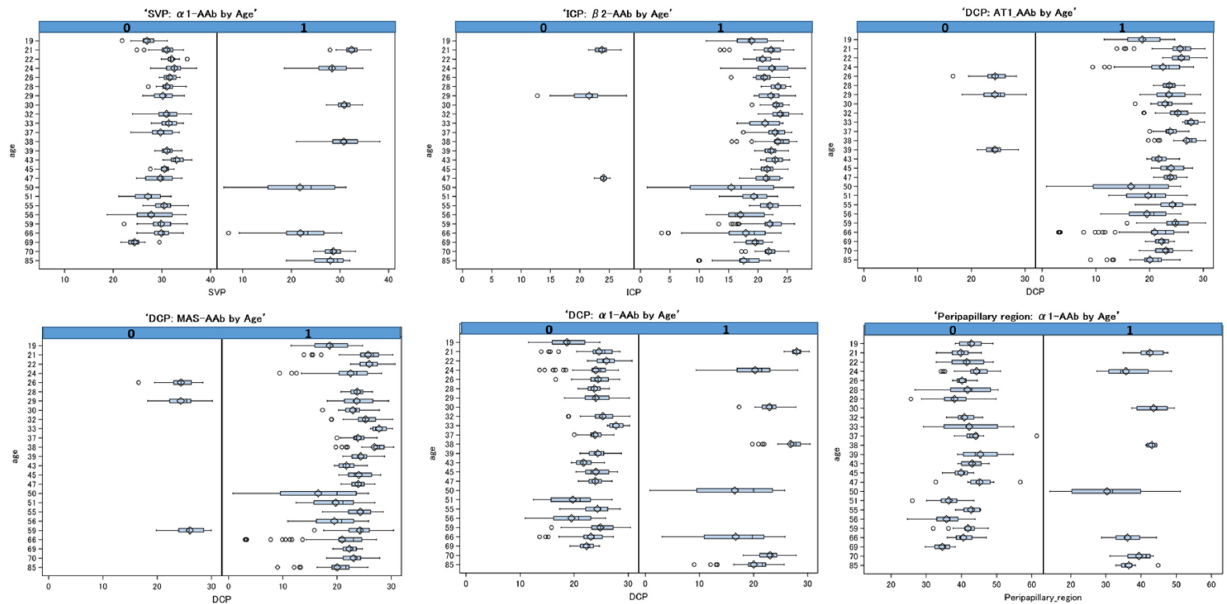
Figure 3. Box plots of vessel density of SVP, ICP, DCP and peripapillary region with the variable age for the mixed model with repetition. The two panels show the distribution of vessel density for patients with Long COVID and a seropositivity (=1) and seronegativity (=0) for α 1-AAb, AT1-AAb, MAS-AAb, and β 2-AAb. The effects are significant ( p < 0.05); SVP—superficial vascular layer; ICP—intermediate capillary plexus; DCP—deep capillary plexus.